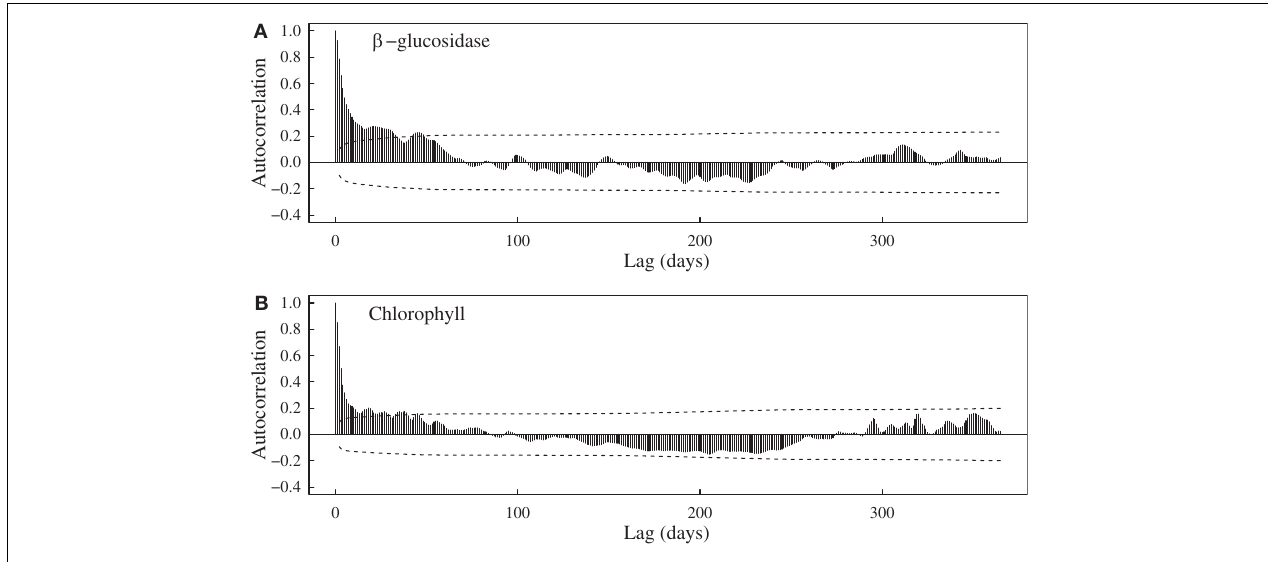
FIGURE 2 |Autocorrelation functions for (A) bulk seawater β -glucosidase activities at Newport Pier and (B) chlorophyll a concentrations derived